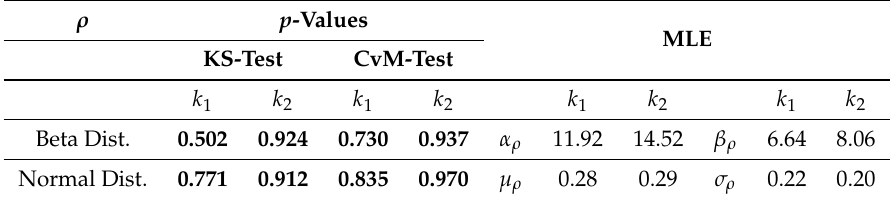
Figure 2. Possible and empirical distributions of ρ . ( a ) k 1 = 50; ( b ) k 1 = 100. Table 1. Parameters and p -values for ρ